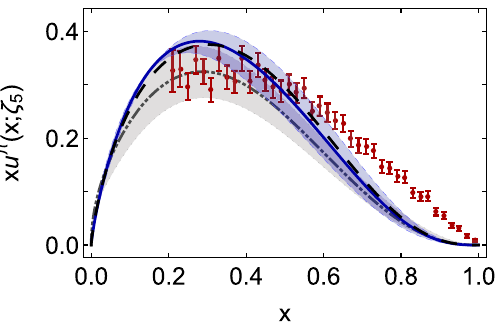
Fig. 6 Solid blue curve – valence-quark distribution in Eq.(29) evolved to ζ = ζ 5 = 5 . 2GeV, using the procedure explained in Sect.4.1; long-dashed black curve – result from Ref. [102] at this scale; anddot-dot-dashed(grey)curvewithinshadedband–lQCDresult[55]. Data (red) – DF as determined in a straightforward LO analysis [111]. Comparingourcentralpredictionwiththedataplottedhere,oneobtains χ 2 / d . o . f . = 19 . 4. (The uncertainty bands bracketing our results are explained in the